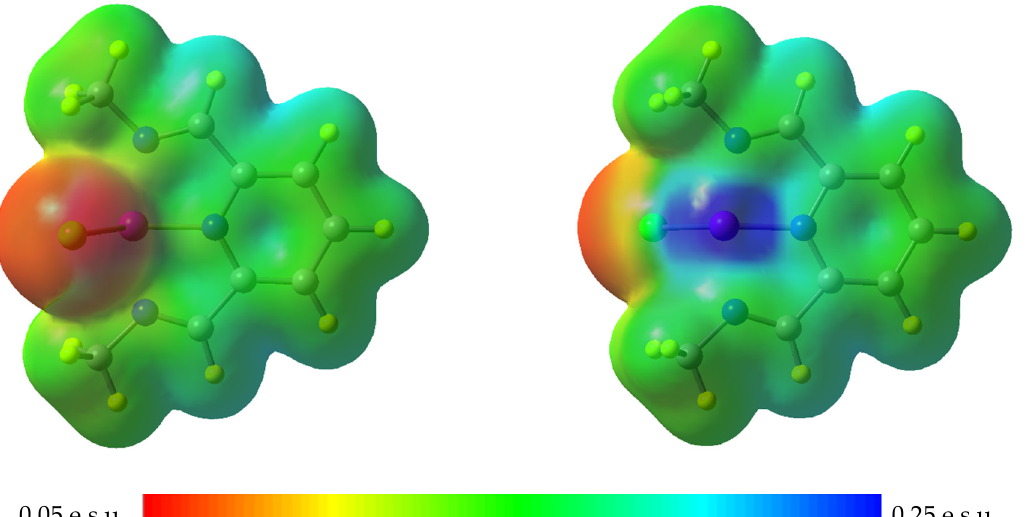
Figure 3. Electrostatic potential mapped on the electron density isosurface at ρ = 0.004 e/a.u. 3 for the N , N -dimethyl system [L(Me) 2 FeCl] + . The surface map on the left shows the ligand face from the side of the axial chloride.